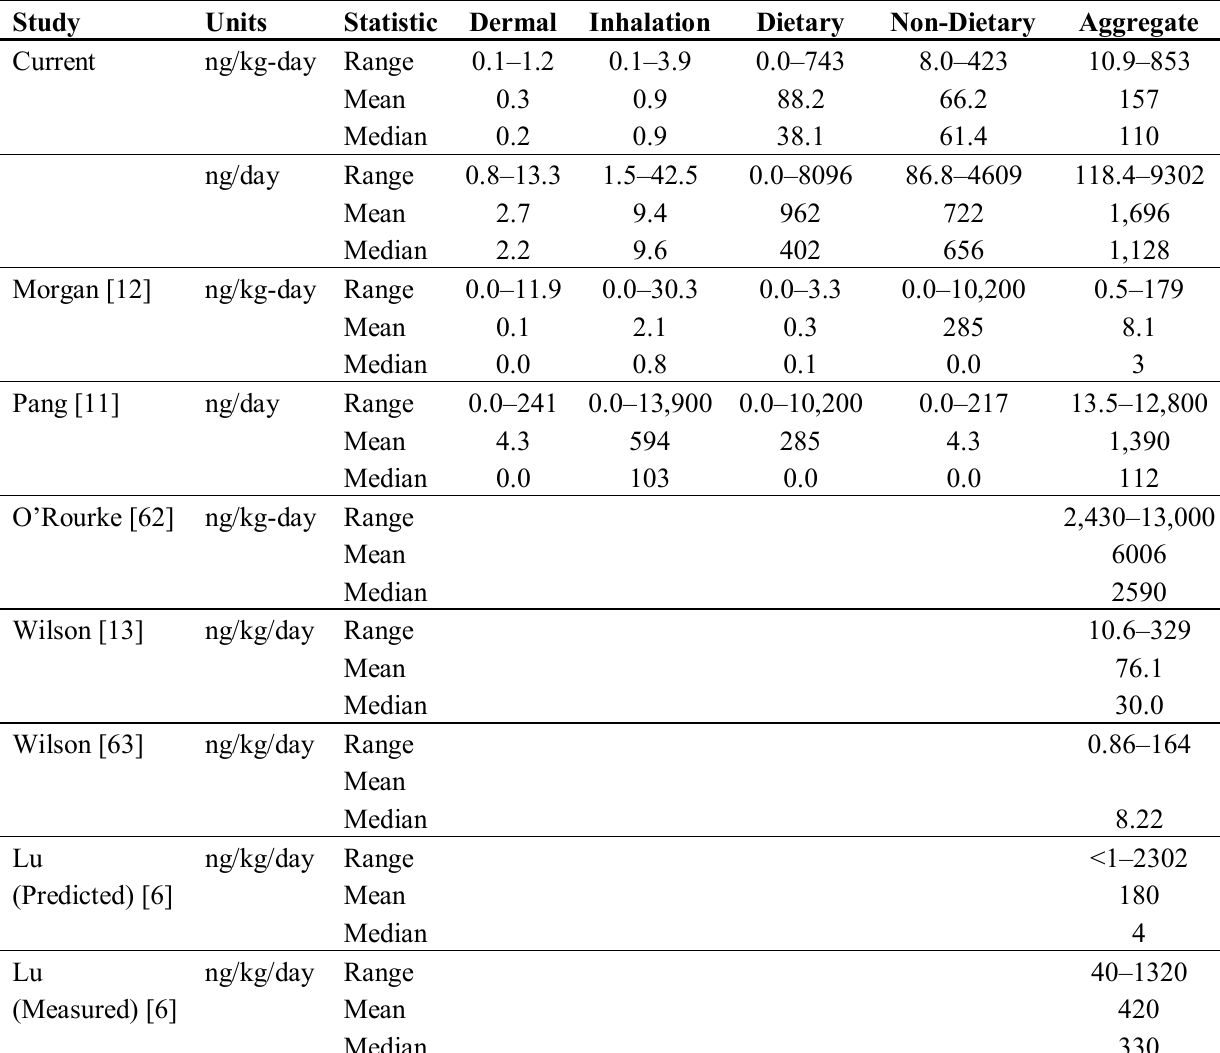
Table 9. Comparison of route-specific and aggregate dose estimates from CACHED and other